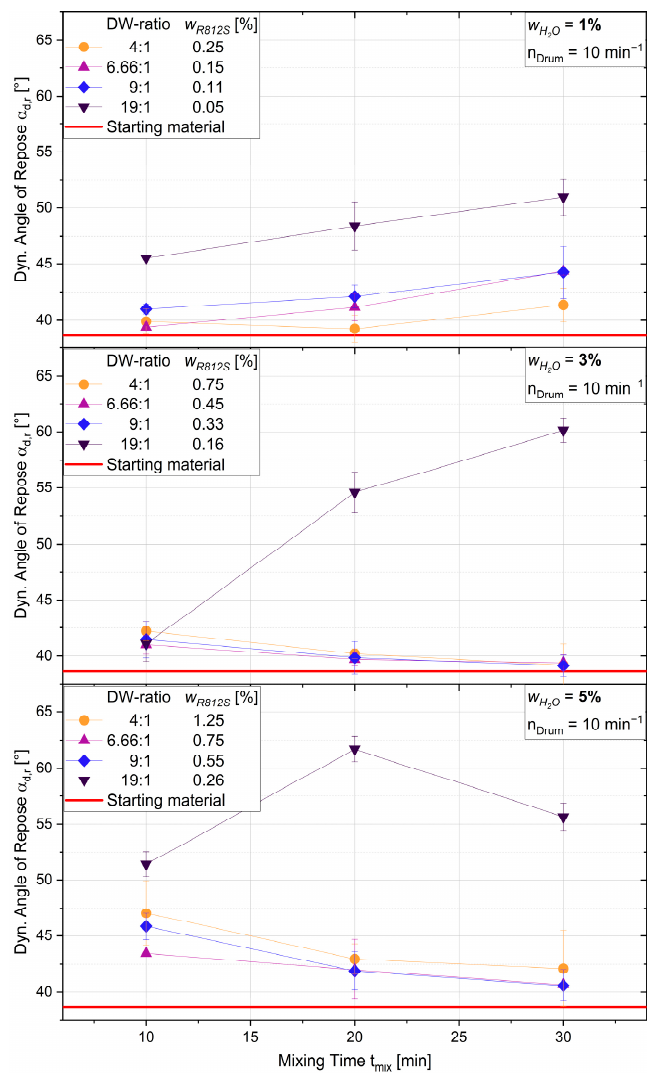
Figure 10. Dynamic angle of repose in dependence of the mixing time for mixtures containing different dry water variants and total water contents: w H2O = 1% ( top ), w H2O = 3% ( centre ) and w H2O = 5% ( bottom ).